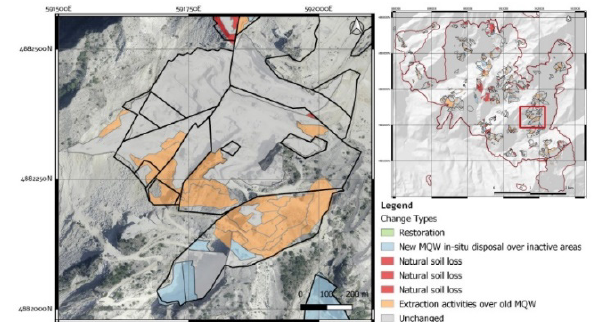
Figure 5 . Sample site with land cover changes between 2009 and 2020 (1:5.000): relevant change types between 2009 and 2020: (a) Natural Soil Loss (red), Extraction Activities Over Old MQW (orange), New MQW in-situ Disposals Over Inactive Areas (cyan). Black outlines represent quarries’ own properties extents. Background: 2019 orthoimage.